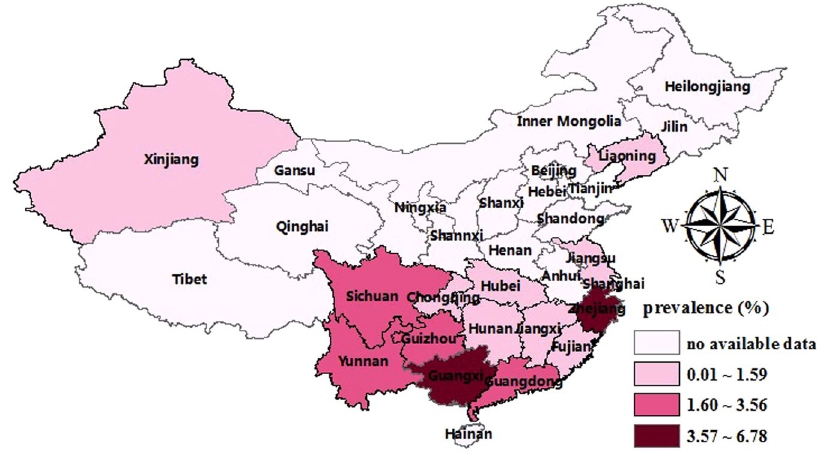
Figure 6. Distribution of the prevalence of β -thalassemia in different regions of mainland China.